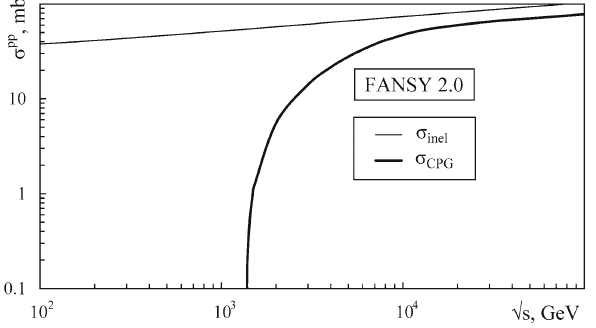
Fig. 4 Energy dependence of cross section of coplanarization process ( s simulation, σ CPG inel